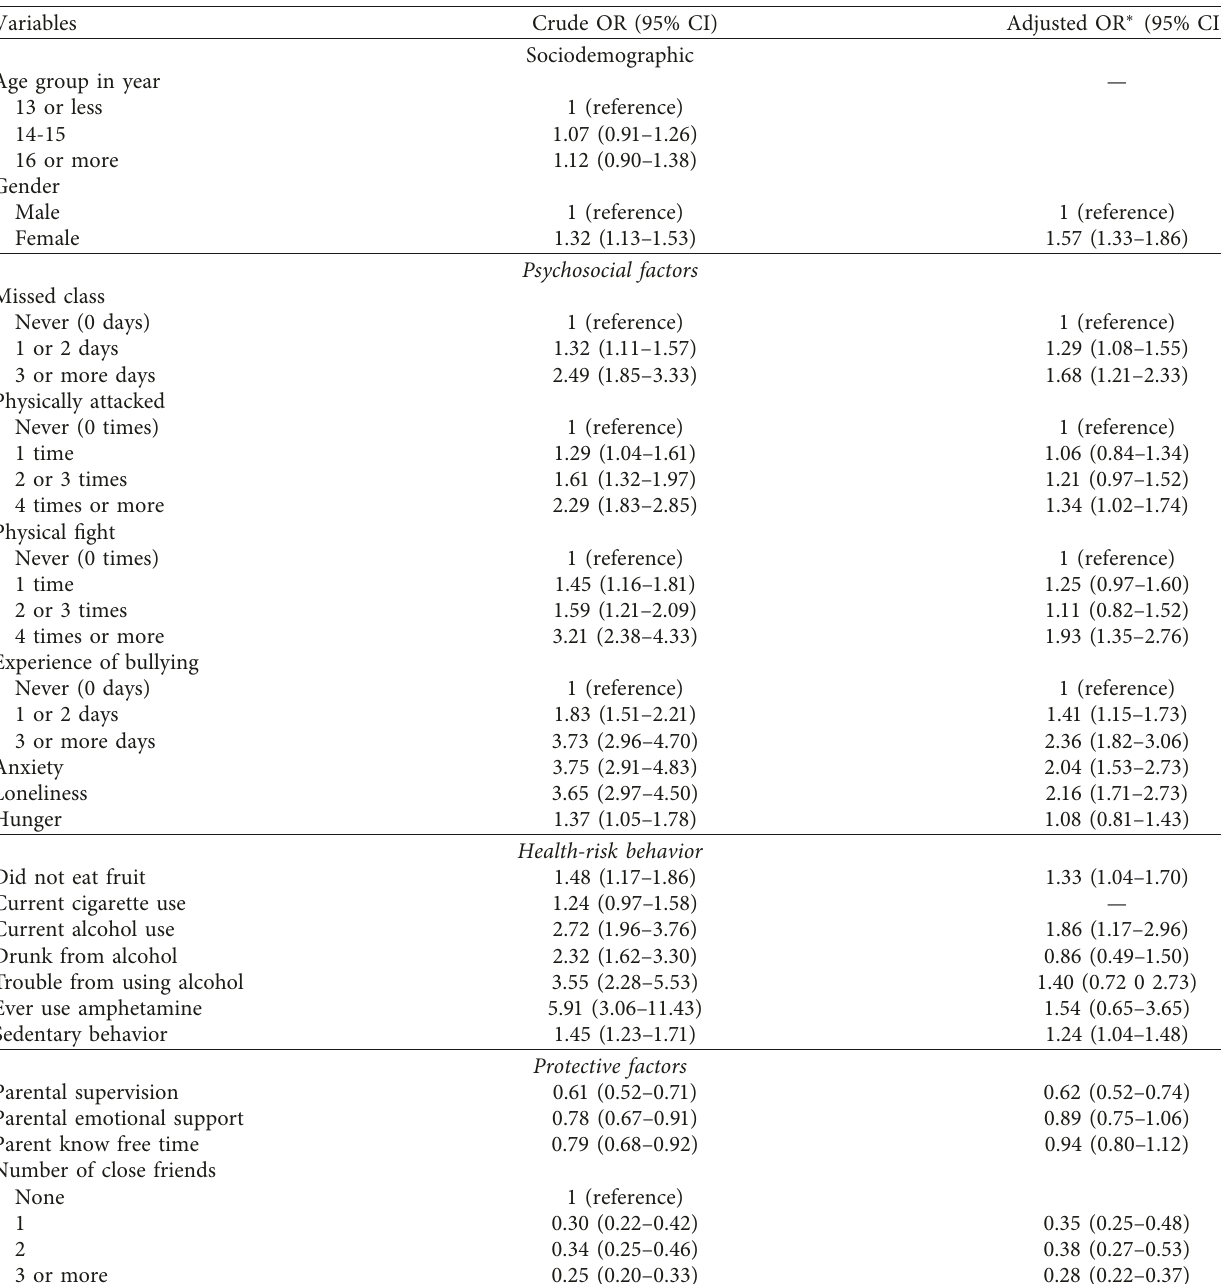
Table 3: Logistic regression analysis for factors associated with suicidal